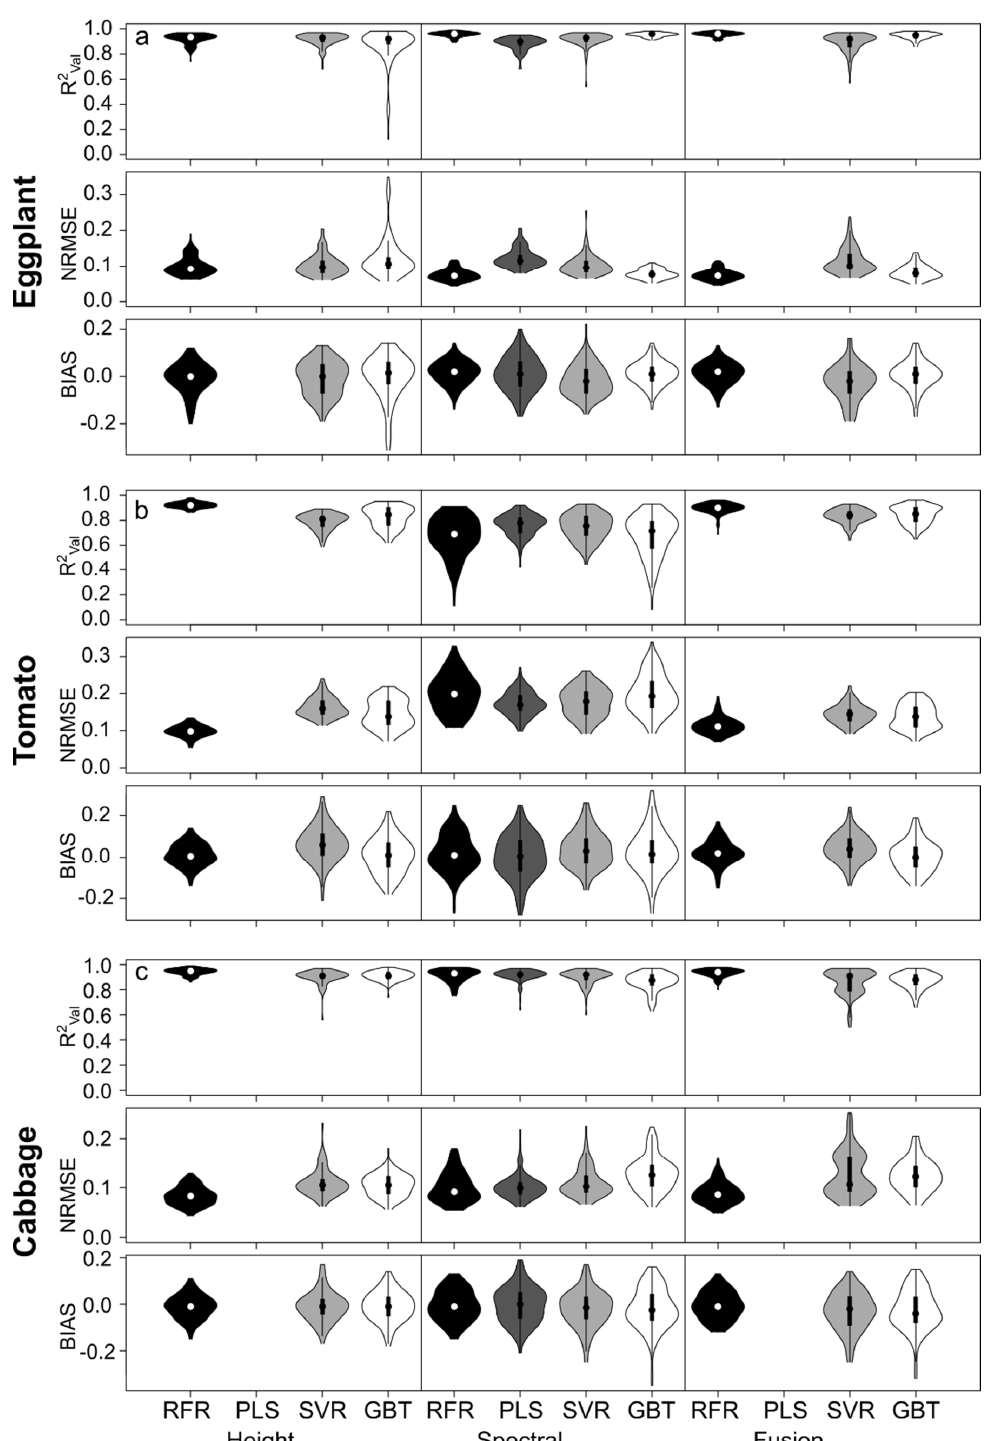
Figure 4. Results from cross-validation using three sets of variables (left: height, middle: spectral, and right: fusion) and machine learning approaches (Random Forest (RFR), Partial Least Squares (PLS), Support Vector (SVR), and Gradient Boosting Tree (GBT)). The distribution of the normalized prediction error ( rel.RMSE ) the coe ffi cient of determination ( R 2 ) and the bias is shown as a violin plot val (Potter et al., 2006) for ( a ) eggplant, ( b ) tomato, and ( c ) cabbage. The areas around the lines indicate the probability density of the